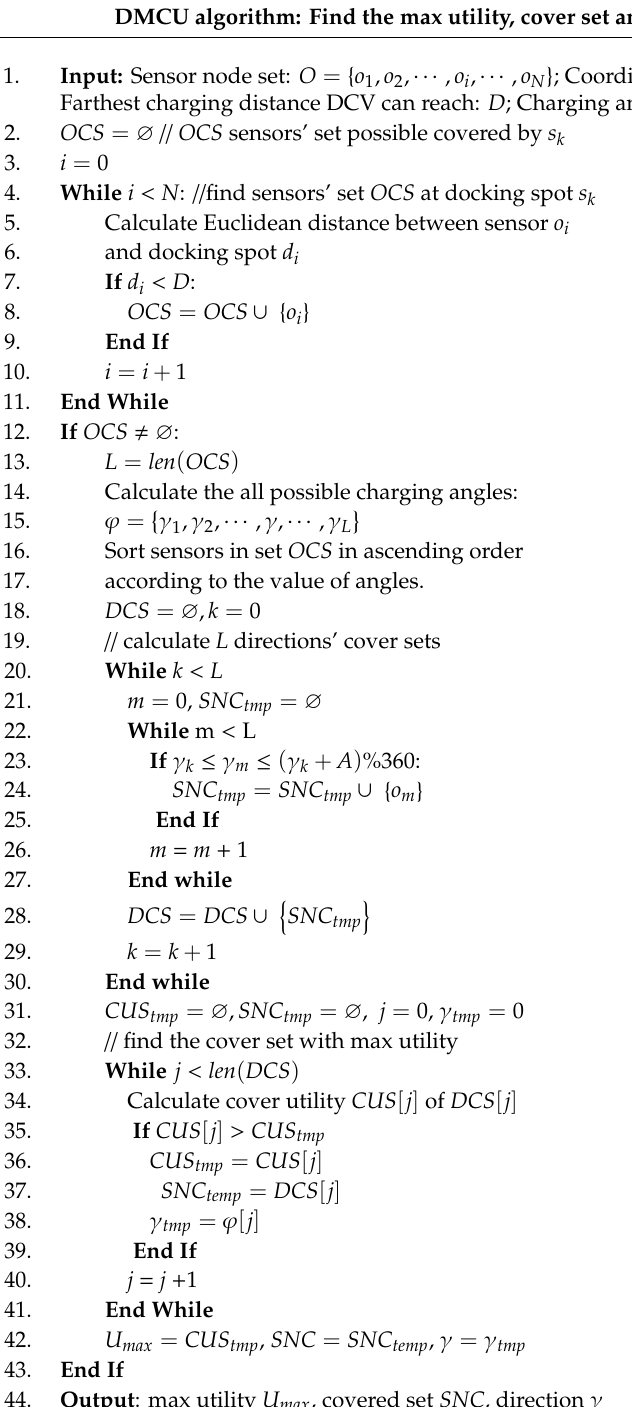
Table 3. The Procedure of the DMCU Algorithm. DMCU algorithm: Find the max utility, cover set and charging orientation at s